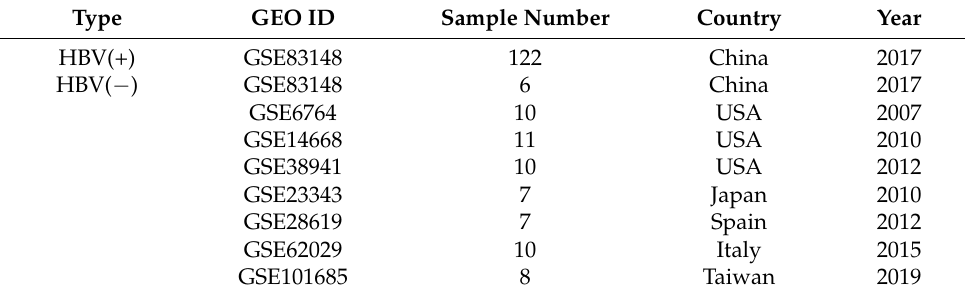
Table 1. The information of GEO microarray datasets used in the